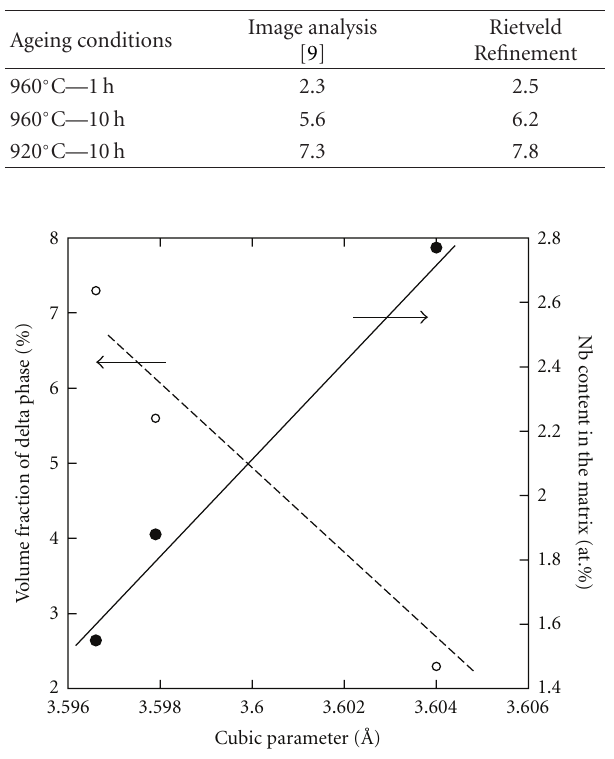
Figure 5: Variation of lattice parameter of the matrix versus volume fraction of delta phase and niobium content in the matrix.